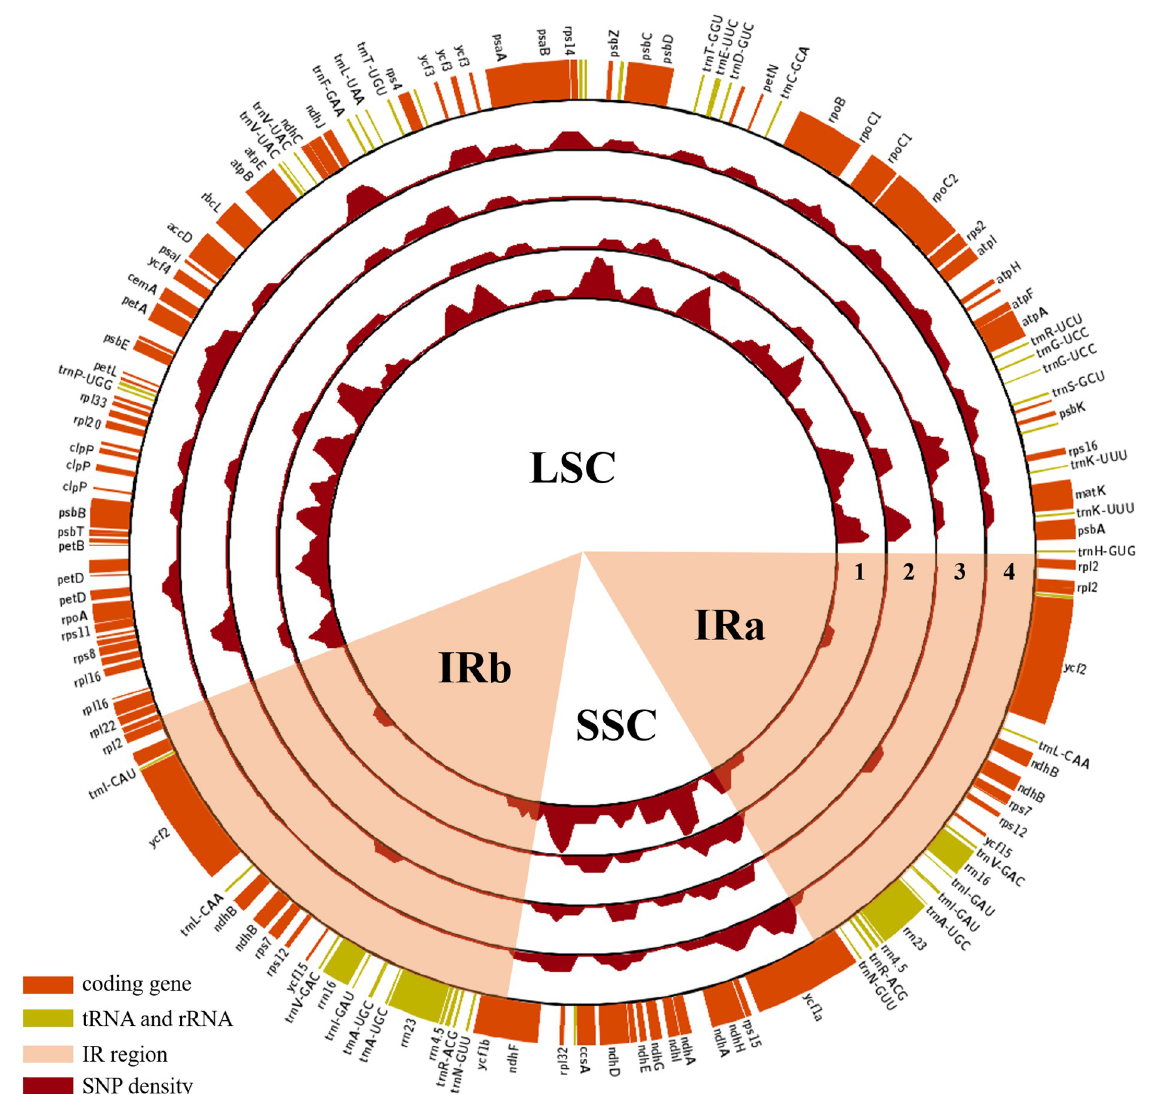
Fig 1. Gene map and plastome variations. SNPs were measured in every 2 kb sliding window with a 500 bp sliding length. 1–4: Maximum variant number scale in each map is 6; 1. E . hamiltonianus (Hantaek)- specific SNP density map; 2. E . hamiltonianus (Hongcheon)-specific SNP density map; 3. E . hamiltonianus (Jeju)-specific SNP density map; 4. E . hamiltonianus (‘Snow’)-specific SNP density map.